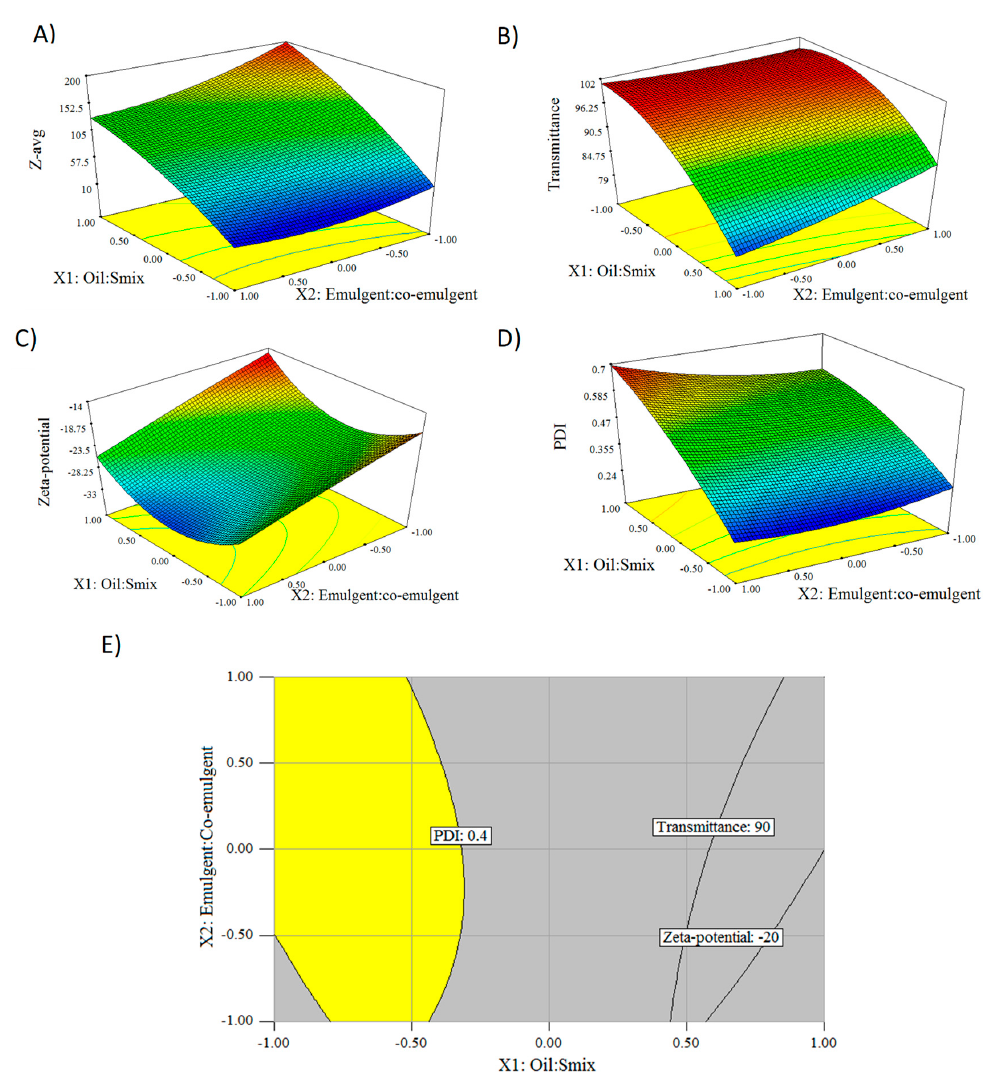
Figure 4. 3D response surface plots for effect of oil:S mix ratio (X 1 ) and emulgent:co-emulgent ratio (X 2 ) on Z-avg ( A ), Transmittance ( B ), Zeta-potential ( C ), and PDI ( D ). Overlay plot ( E ) for various oil:S mix and emulgent:co-emulgent ratios, where the area that satisfies the constraints is yellow, while the area that does not meet criteria is grey.